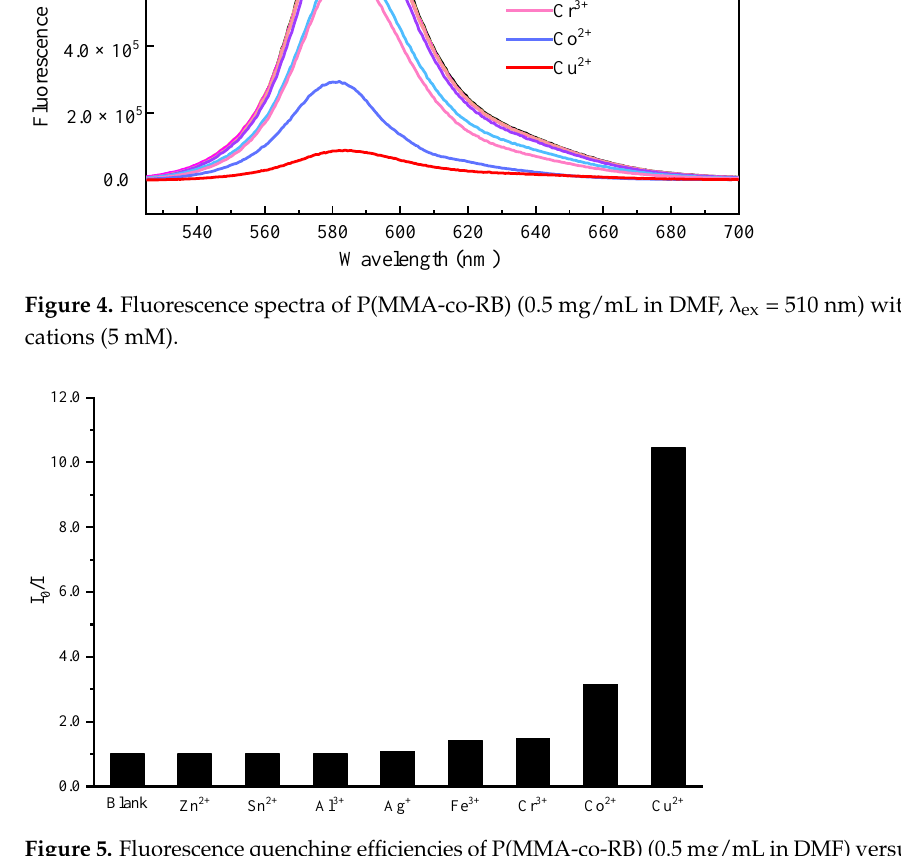
Figure 5. Fluorescence quenching efficiencies of P(MMA-co-RB) (0.5 mg/mL in DMF) versus different metal cations (5 mM).